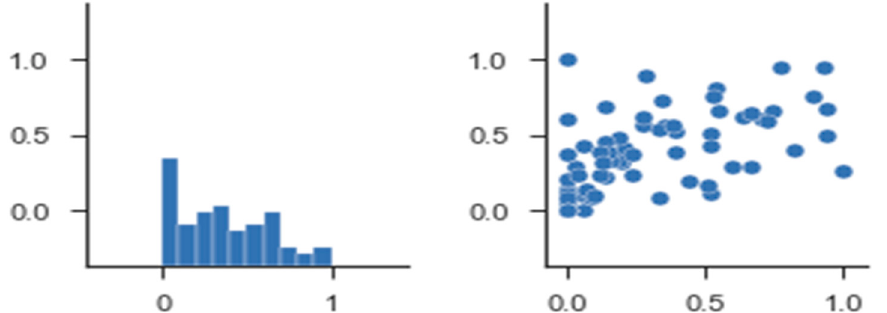
Figure 12. Performance analysis of predication accuracy.